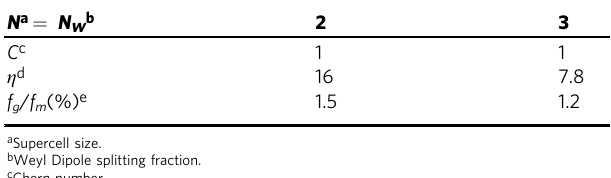
Table 1 Reduction of the magnetic bias η and of the topological gap-to-midgap ratio f g / f m (%), still achieving the same Chern number C . Source data are provided as a Source Data fi le.